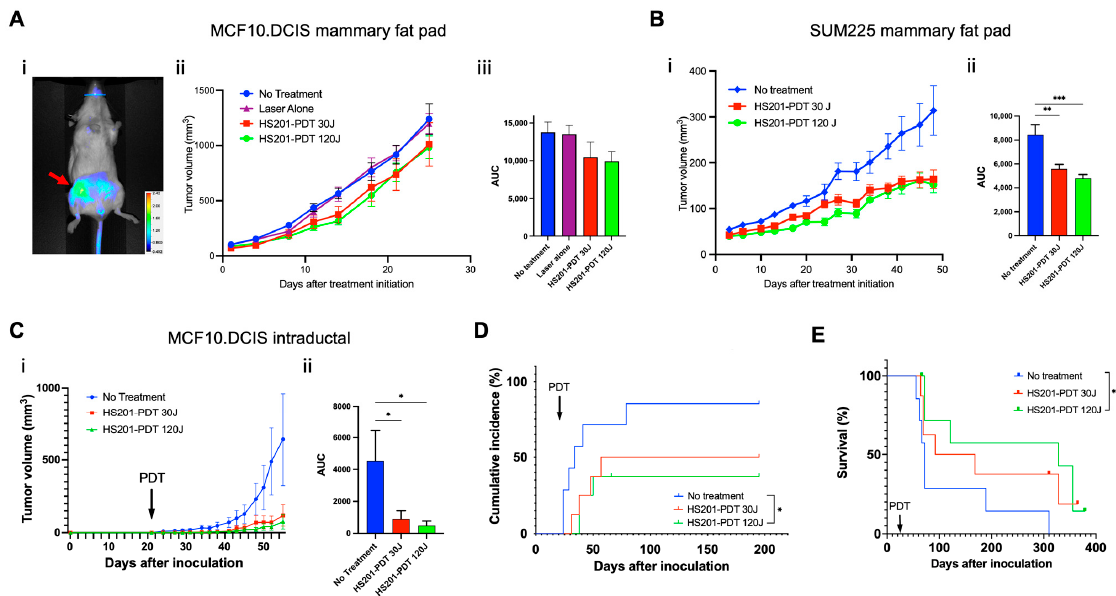
Figure 2. Antitumor efficacy of in vivo HS201-PDT against human DCIS cell lines. Antitumor efficacy of HS201-PDT against MCF10DCIS.com cells in mammary fat pad implantation model. MCF10DCIS.com cells and SUM225CWN cells (1 × 10 6 cells/mouse) were inoculated into the 4th